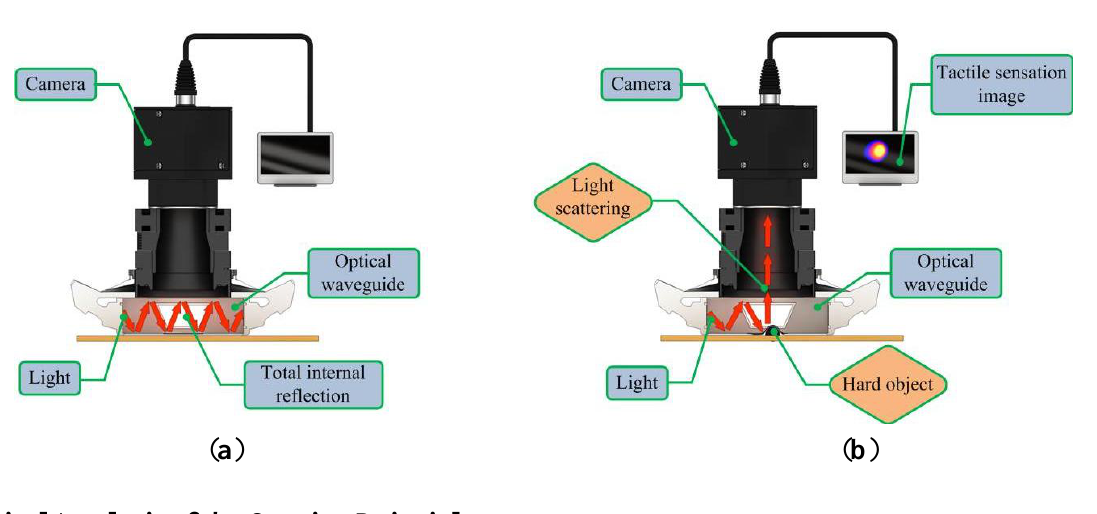
Figure 2. The schematic diagram of the imaging principle. ( a ) The light is injected to the waveguide for total reflection. ( b ) The light scatters as the waveguide deforms according to the external force presented by a hard